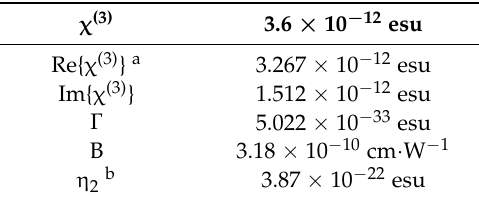
Table 9. Optical properties of tetrachloro (1,10-phenanthroline- N,N’ ) tin(IV).